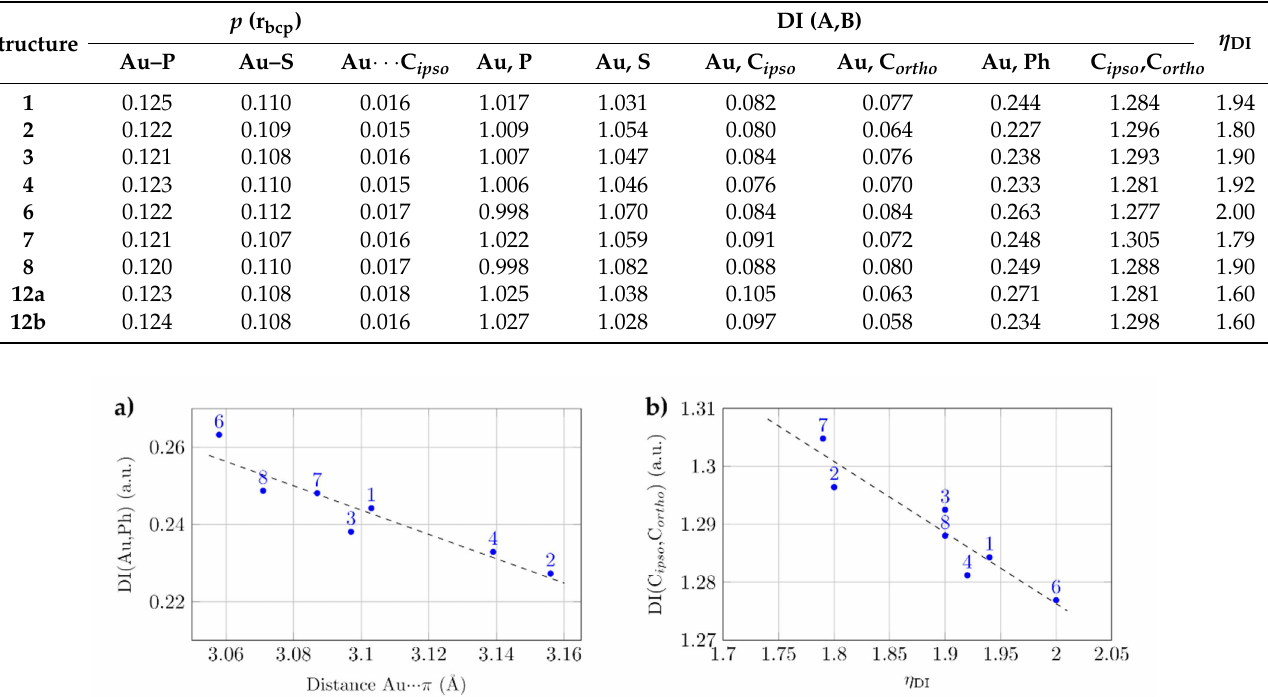
Table 3. Selected ρ ( r bcp ) and DI obtained from QTAIM analyses of the electron densities in structures 1 – 4 , 6 – 8 , 12a , and 12b . Atomic units are used throughout.